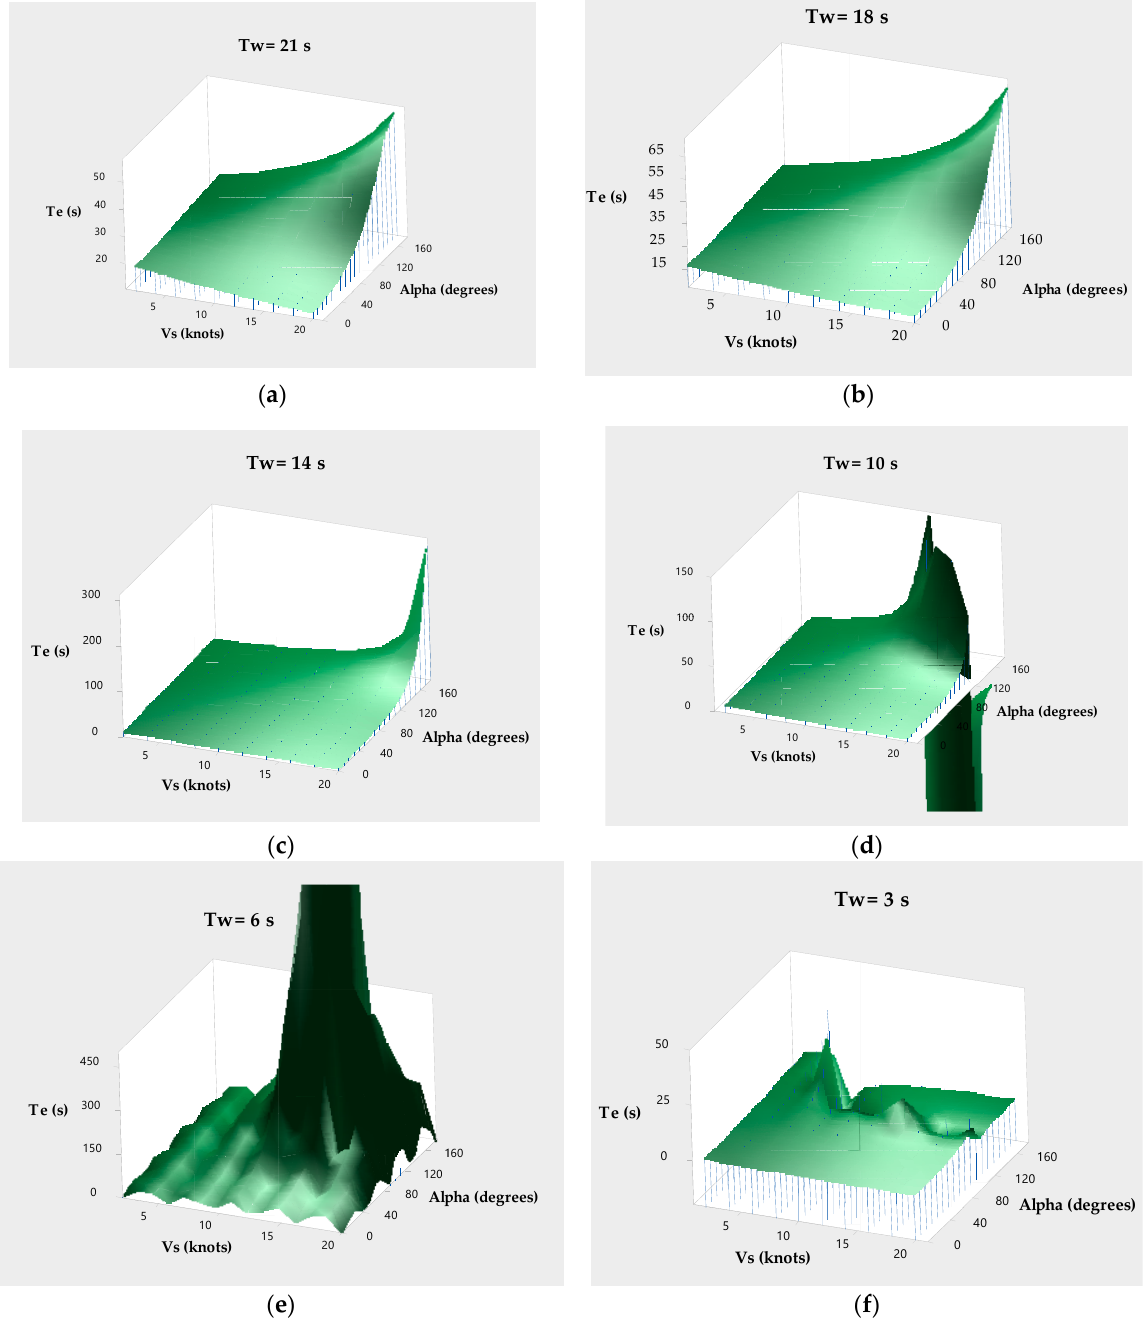
Figure 15. Surface graphs for different sea state conditions. ( a ) Tw = 21 s; ( b ) Tw = 18 s; ( c ) Tw = 14 s; ( d ) Tw = 10 s; ( e ) Tw = 6 s; and ( f ) Tw = 3 s.